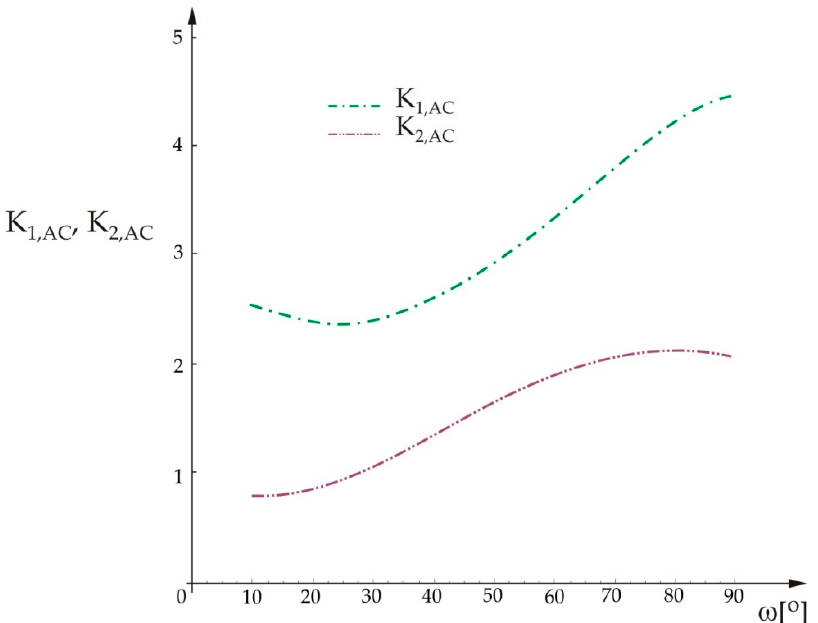
Figure 6. Variation of the real and imaginary parts of the stress intensity factors for the crack that deflects into the AC interface, in terms of angle ω .